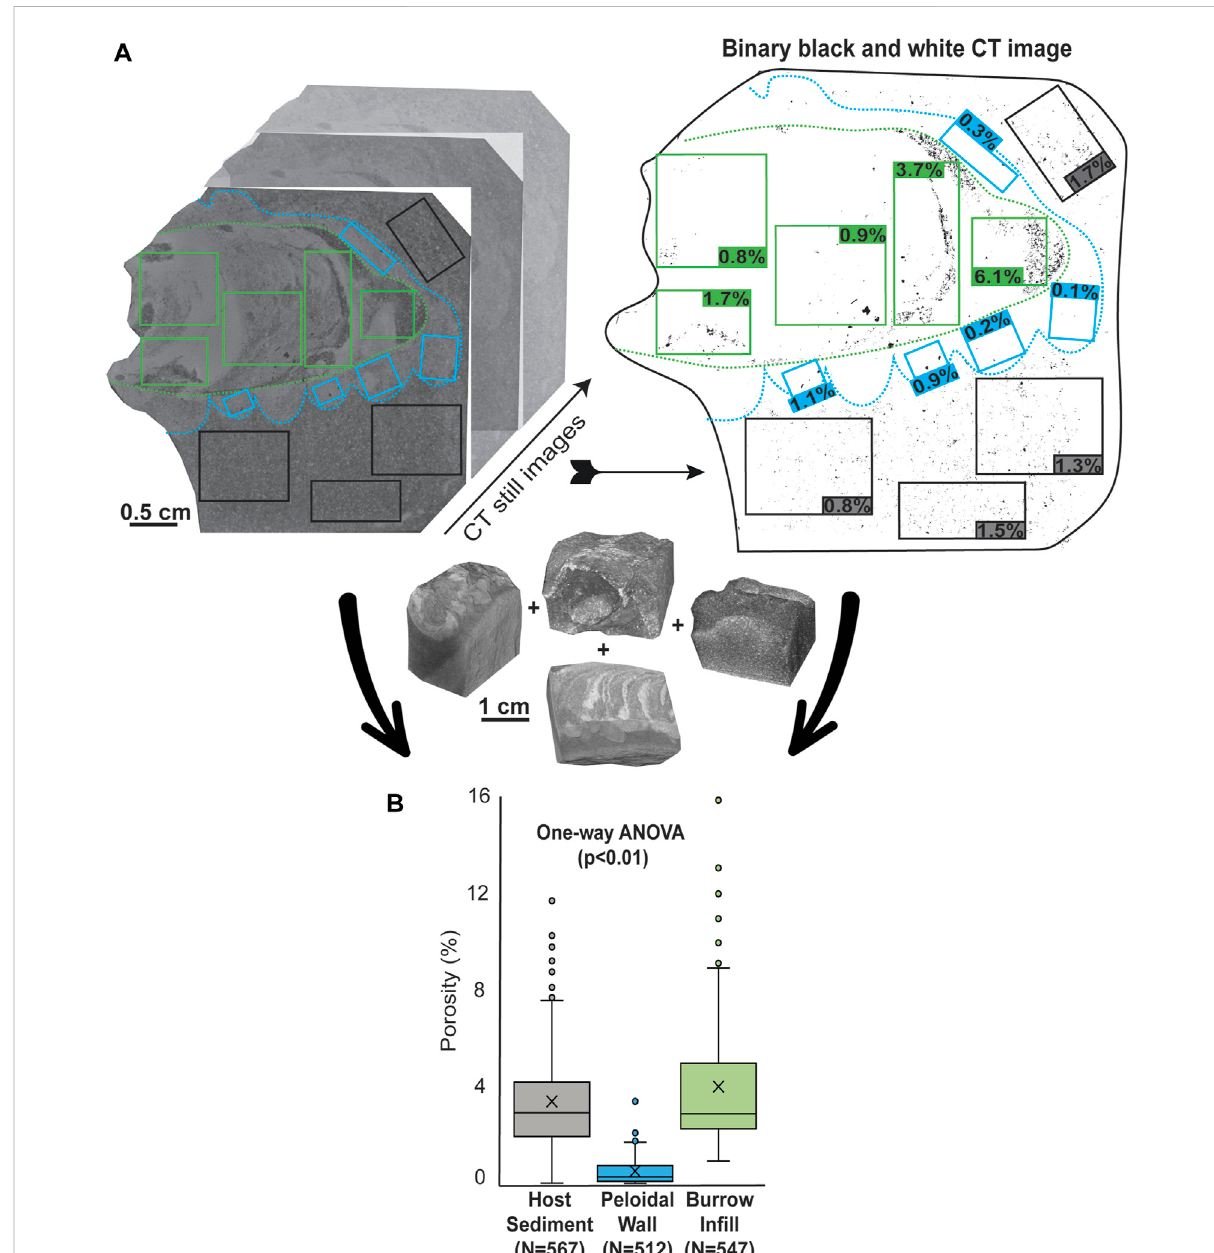
FIGURE 4 (A) Example of Micro-CT still images (left) with associated binary black and white image (right) from one Ophiomorpha sample (specimen Op- 18). Note the Micro-CT binary image with random rectangles from which the porosity measurements were obtained for host sediment (grey rectangles), peloidal wall (blue rectangles), and burrow fi ll (green rectangles). (B) Box plots representing porosity values from the three measured parts of all Ophiomorpha specimens (17 specimens). Note the low porosity values for the peloidal wall and the highly variable porosity for the host sediment and burrow fi